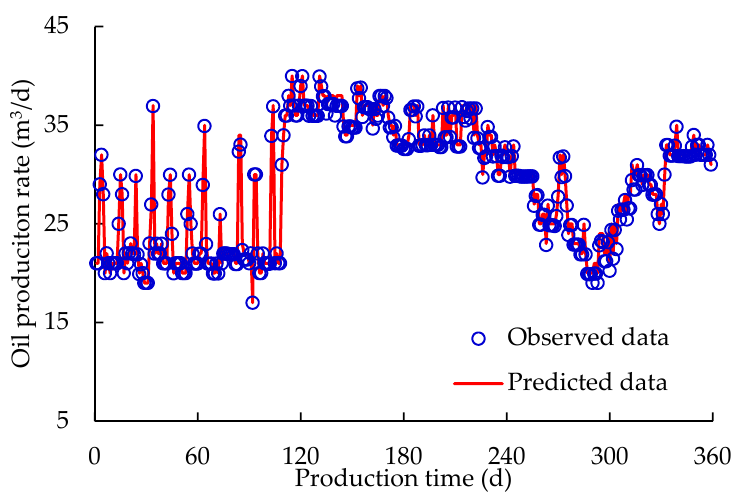
Figure 5. CRMIP oil production match for Pro_1.